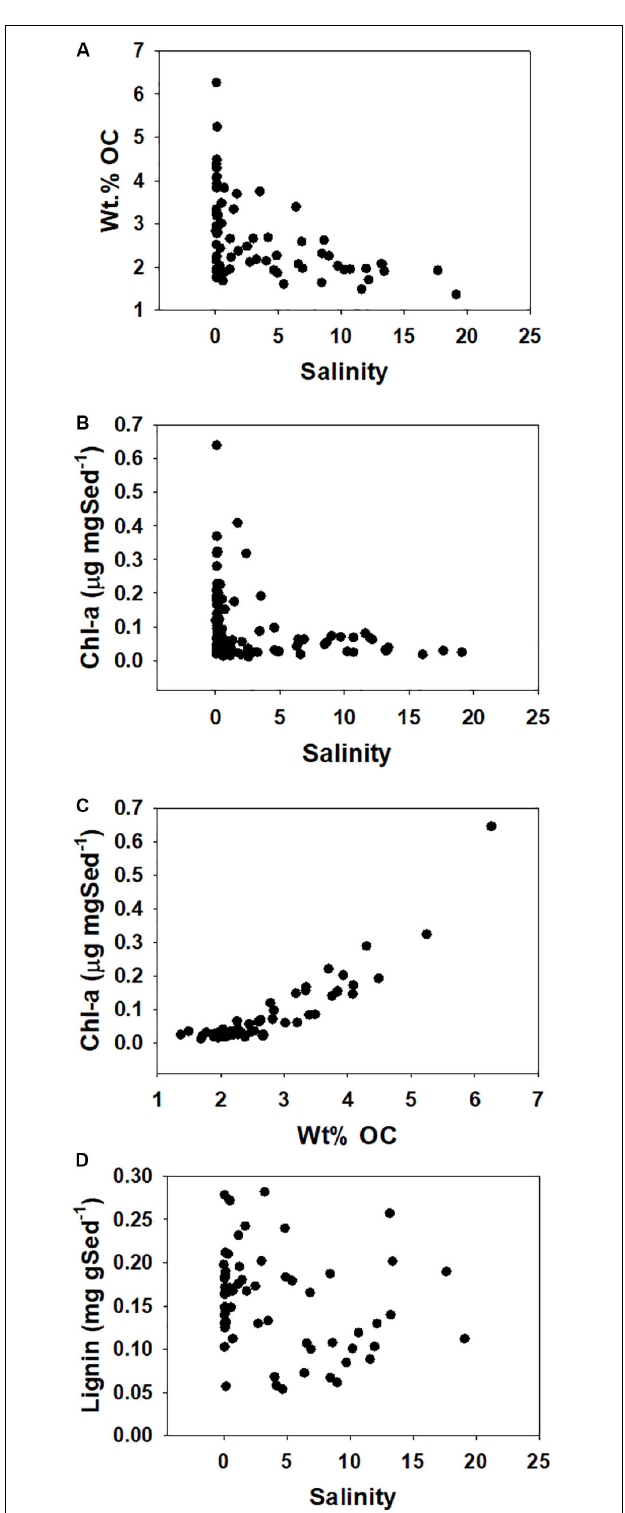
FIGURE 8 | (A) Weight percent OC vs. salinity for all samples. (B) Chlorophyll-a as a sediment concentration vs. salinity. (C) Chlorophyll-a vs. weight percent organic carbon (OC). (D) Lignin as a sediment concentration vs.